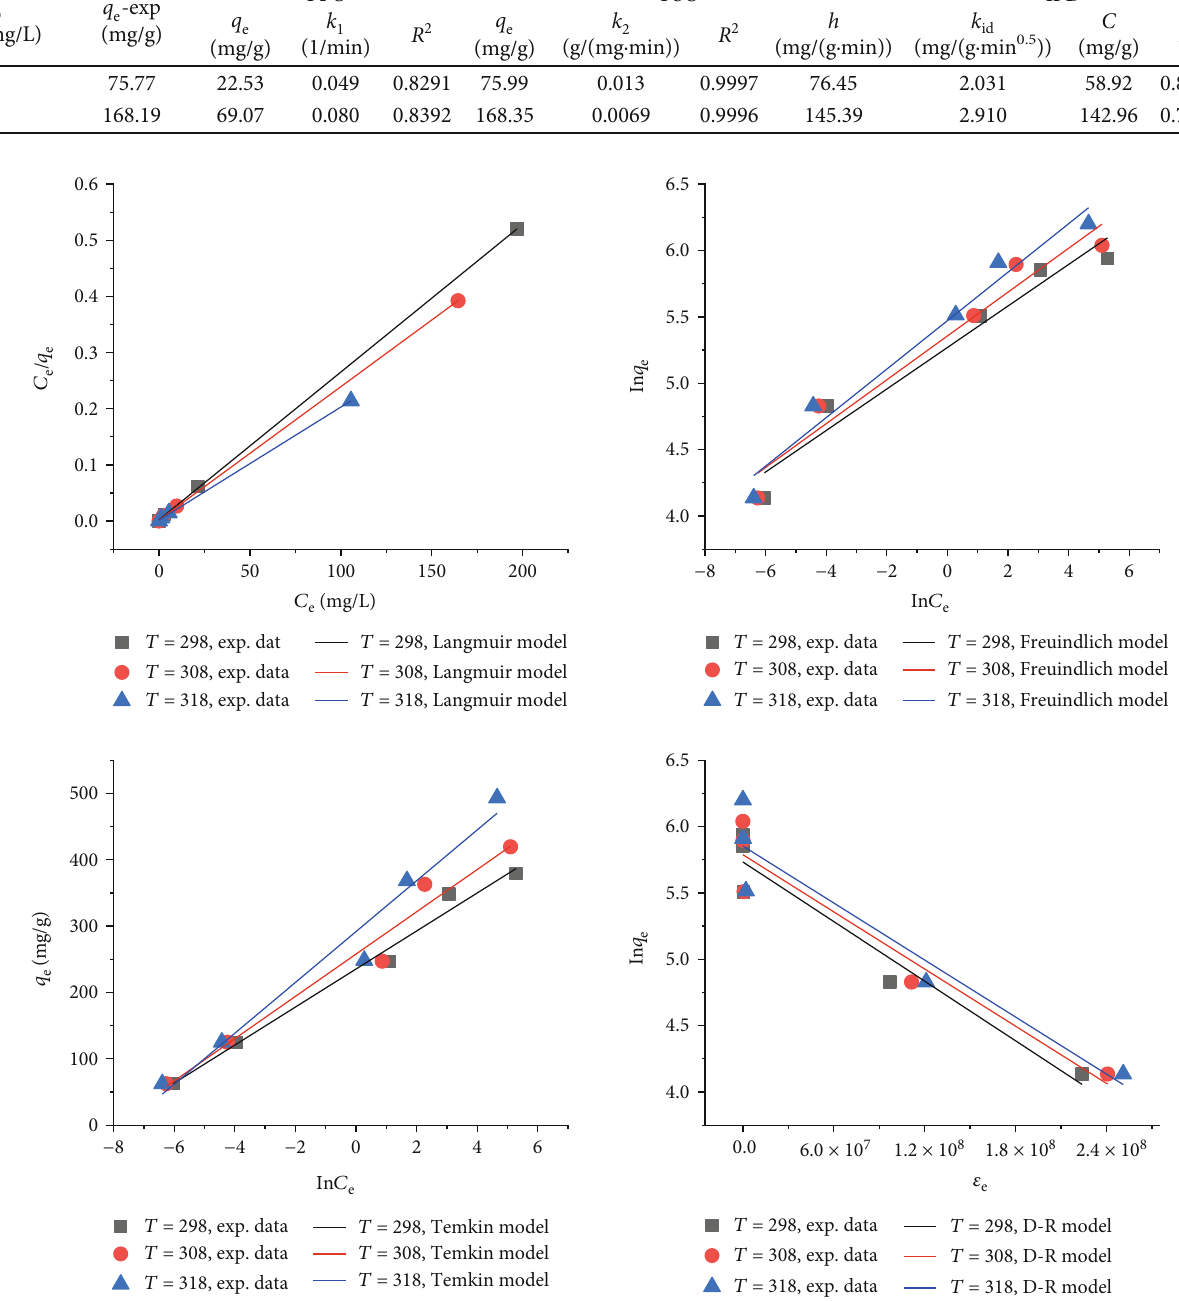
Figure 8: Langmuir, Freundlich, Temkin, and D-R isotherm plots for CV adsorption onto